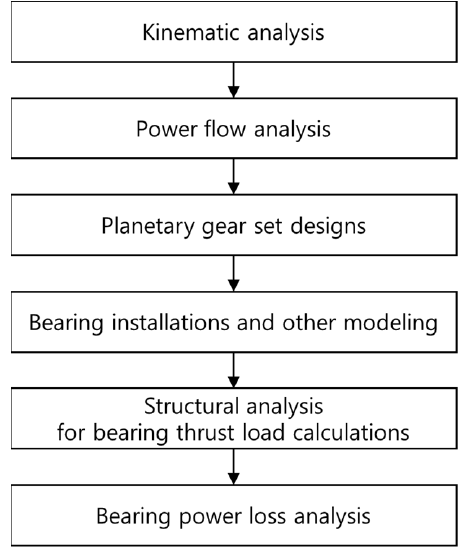
Figure 1. A flowchart describing the entire processes.